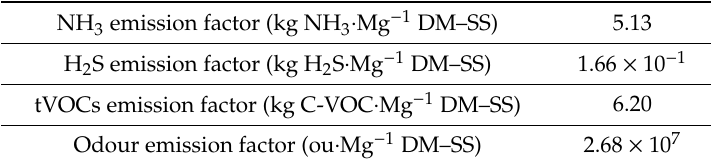
Table 3. NH 3 , H 2 S, tVOCs and odour emission factors, expressed in kg of pollutant per Mg of dry matter of SS and in ou per Mg of dry matter of SS,